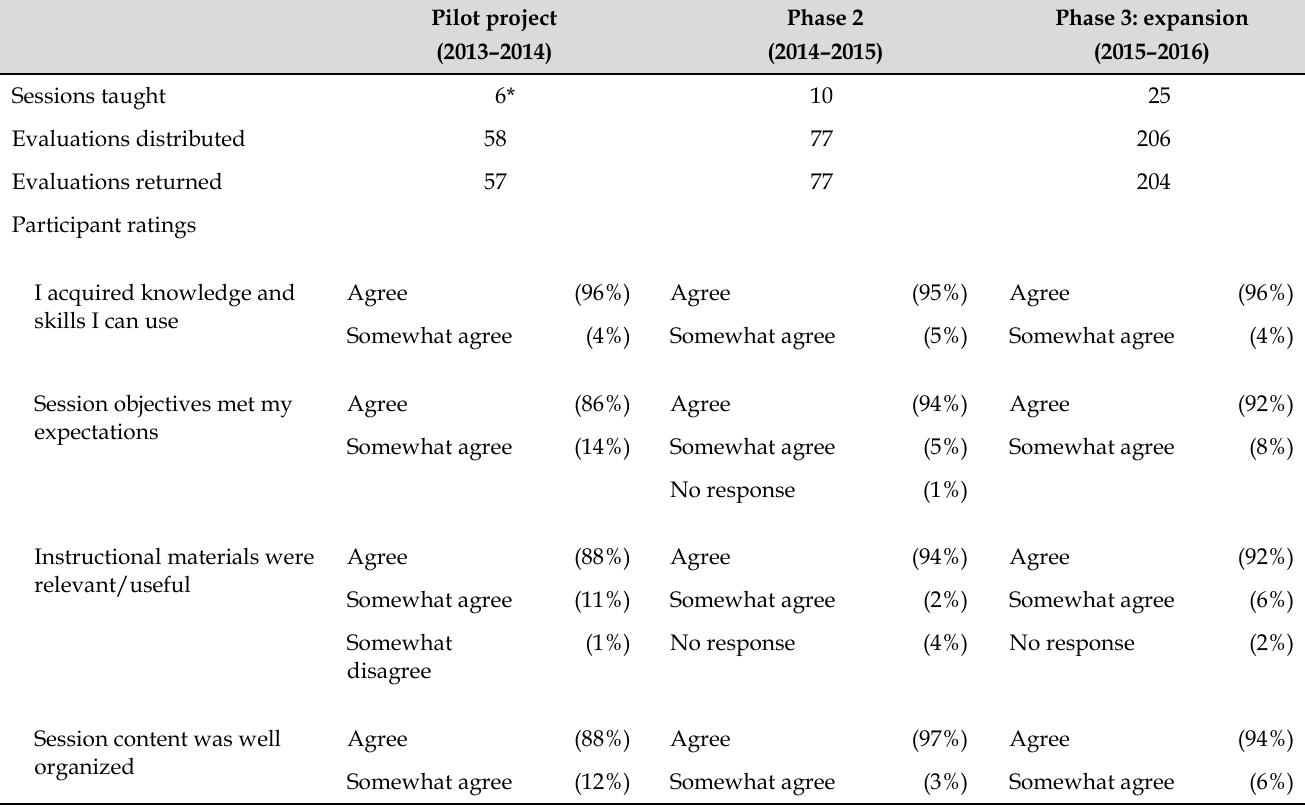
Table 3 Health Information Specialists Program: course evaluation